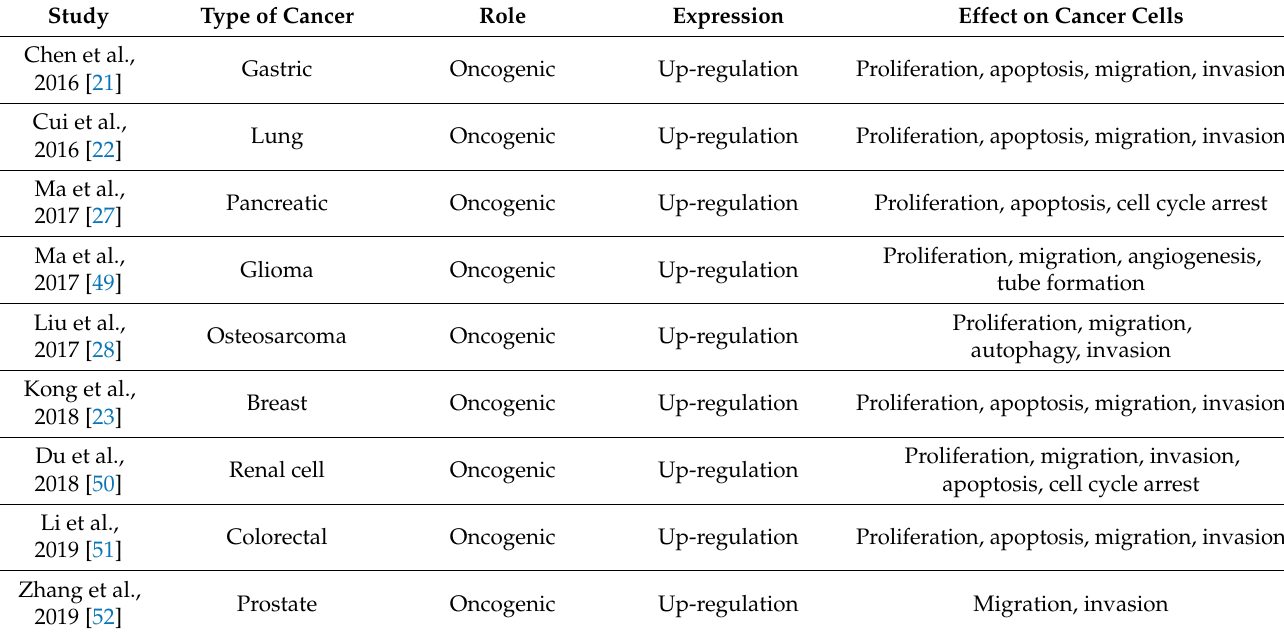
Table 2. Studies indicating SNHG15 expression in different cancer types and its